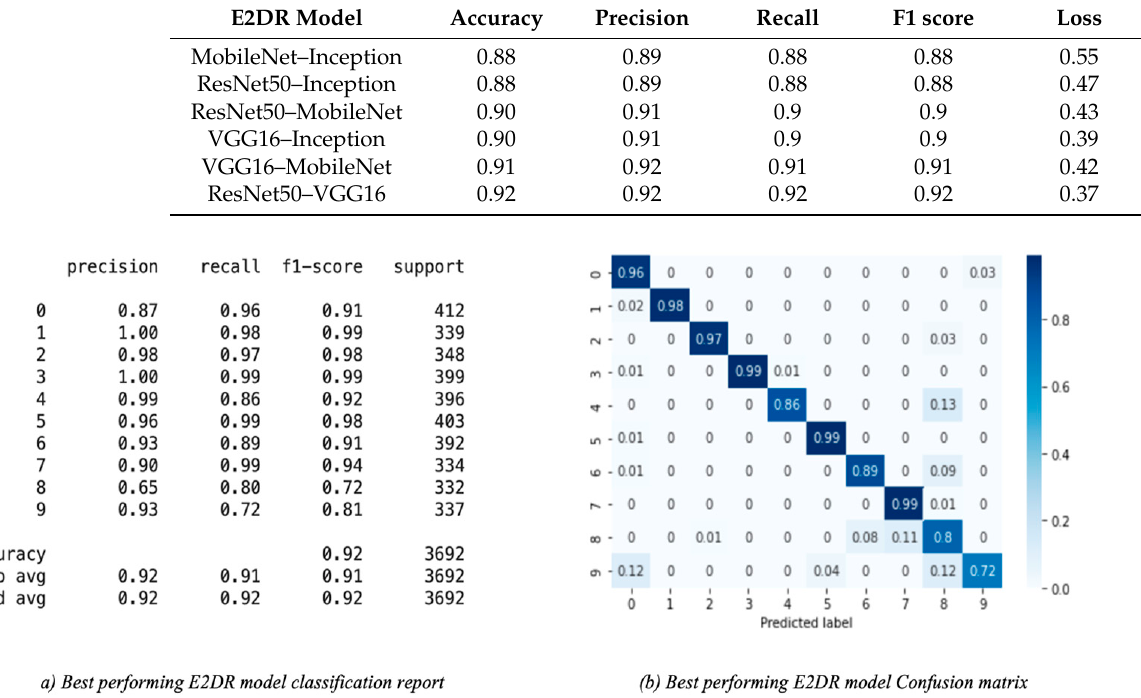
Figure 14. Best performing E2DR model classification report and confusion matrix.